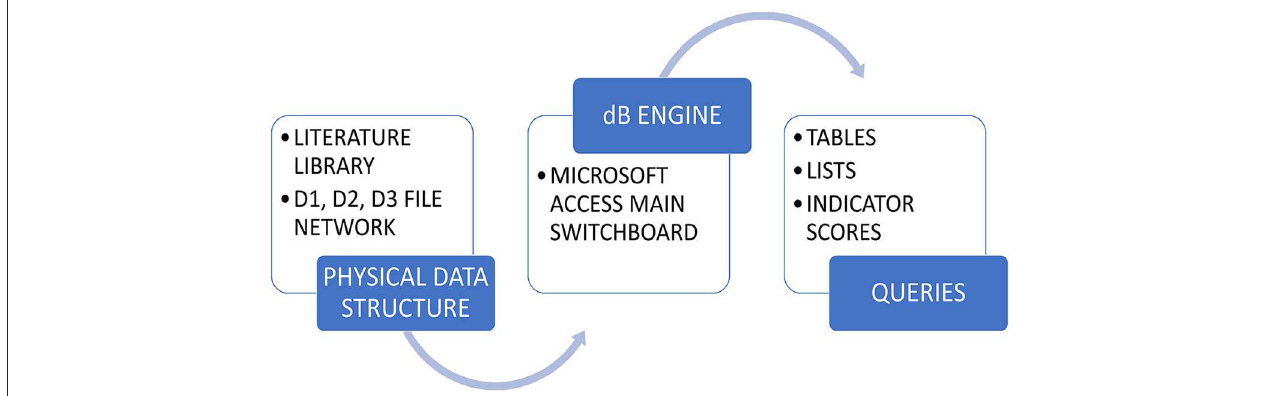
FIGURE 8 | The CRSI data warehouse framework depicting the flow of data and information; access controls; outputs generated; and research asset monitoring and management loop.